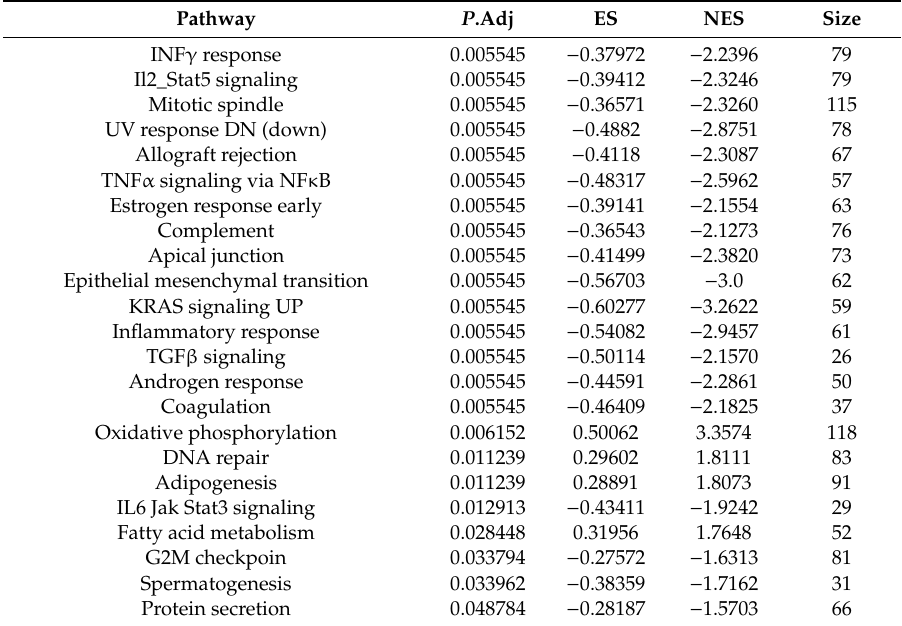
Figure 1. Pathway enrichment of DEGs relative to IQGAP1 downregulation. ( A ) Representatives of top clusters enriched. ( B ) Network presentation of those enriched clusters. Analyses were performed using Metascape [25]. Table 1. Human hallmark gene set enrichment of IQGAP1 DEGs.